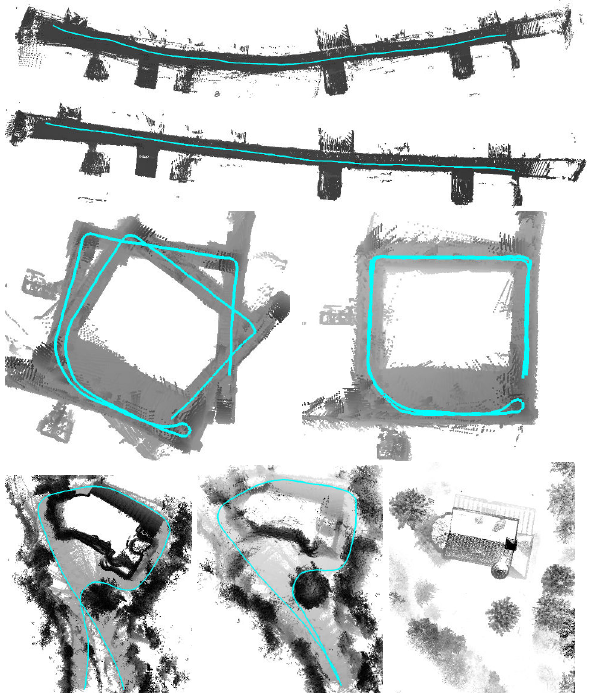
Figure 6. Topview showing the results from the experiments one to three: first, the initial trajectory, second, the results from the continuous-time SLAM algorithm. From top to bottom: ”The Hallway”,”The Circle” and ”The Chapel”. The noisy appearance of the indoor data sets results from reflecting surfaces such as glass. The initial trajectory of ”The Chapel” data set is planar. After correction, the true 3D structure of the surface becomes clear when looking at the shading. As the chapel is lower than Figure 7. Registered point clouds for ”The Hallway” and two the starting position the shading by height has less impact on the perspectives from ”The Chapel”, respective to Fig. 5. The color roof of the chapel which is therefore lighter in color. The third represents the shown scale, ranging from 0 m (blue) to 1m (red) image shows the reference data set collected with a Riegl point-to-point VZ-400 laser scanner.